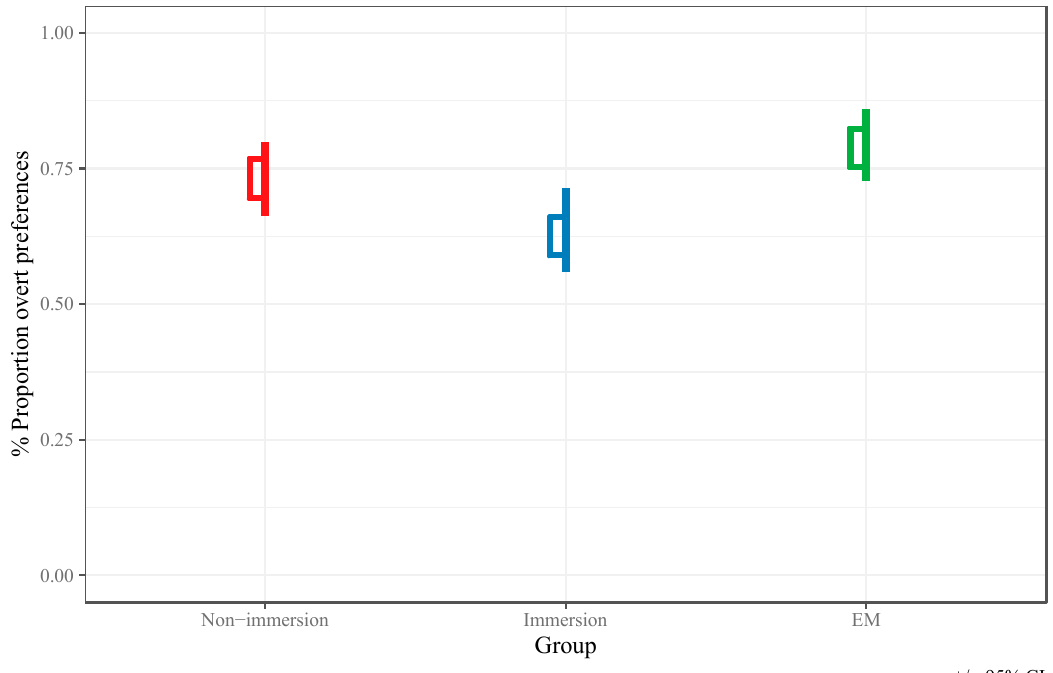
Figure 1. Proportion of overt pronoun responses in English as a function of group.